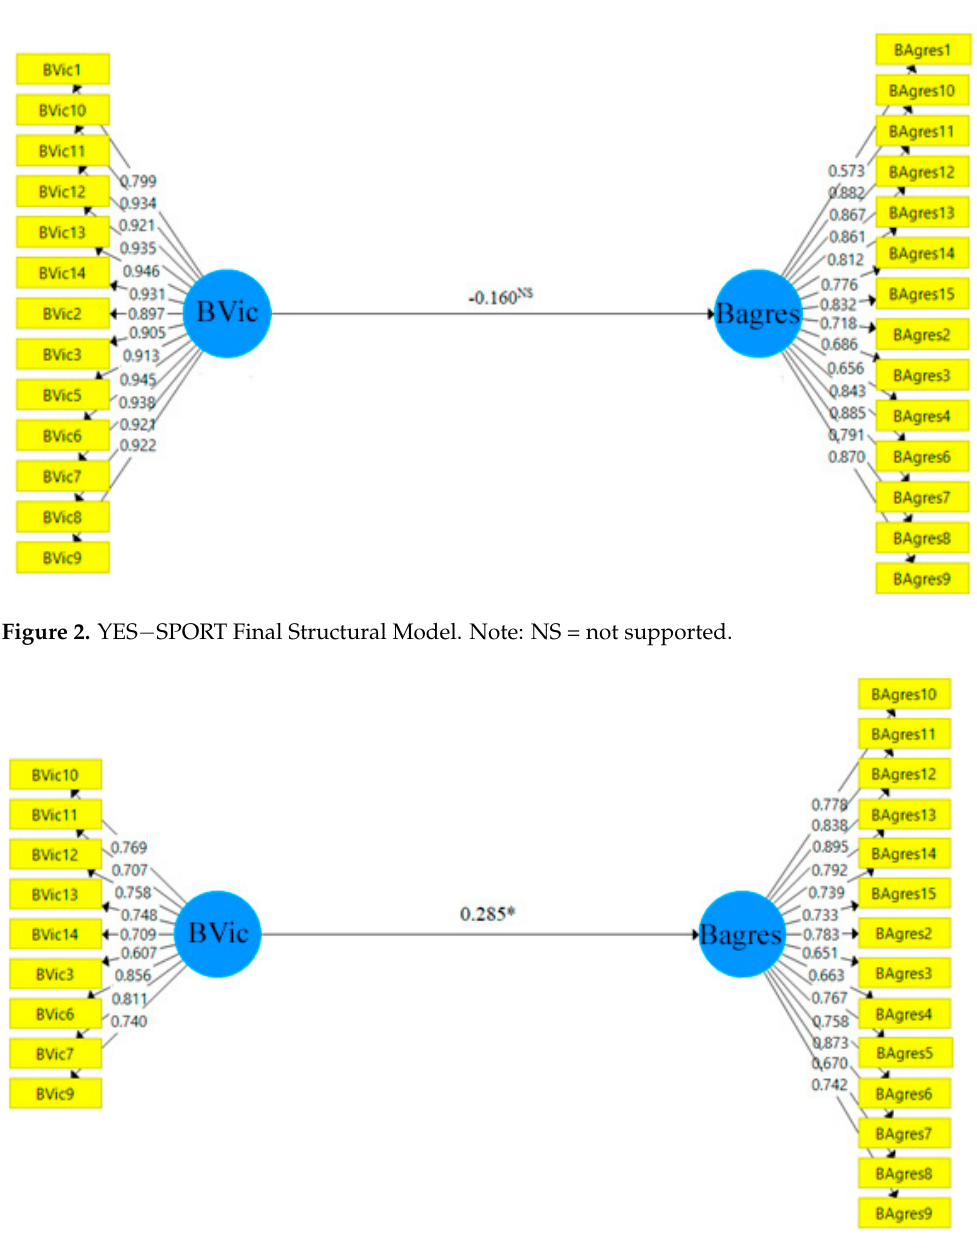
Figure 3. Final structural model NO-SPORT. Note: * p < 0.05.